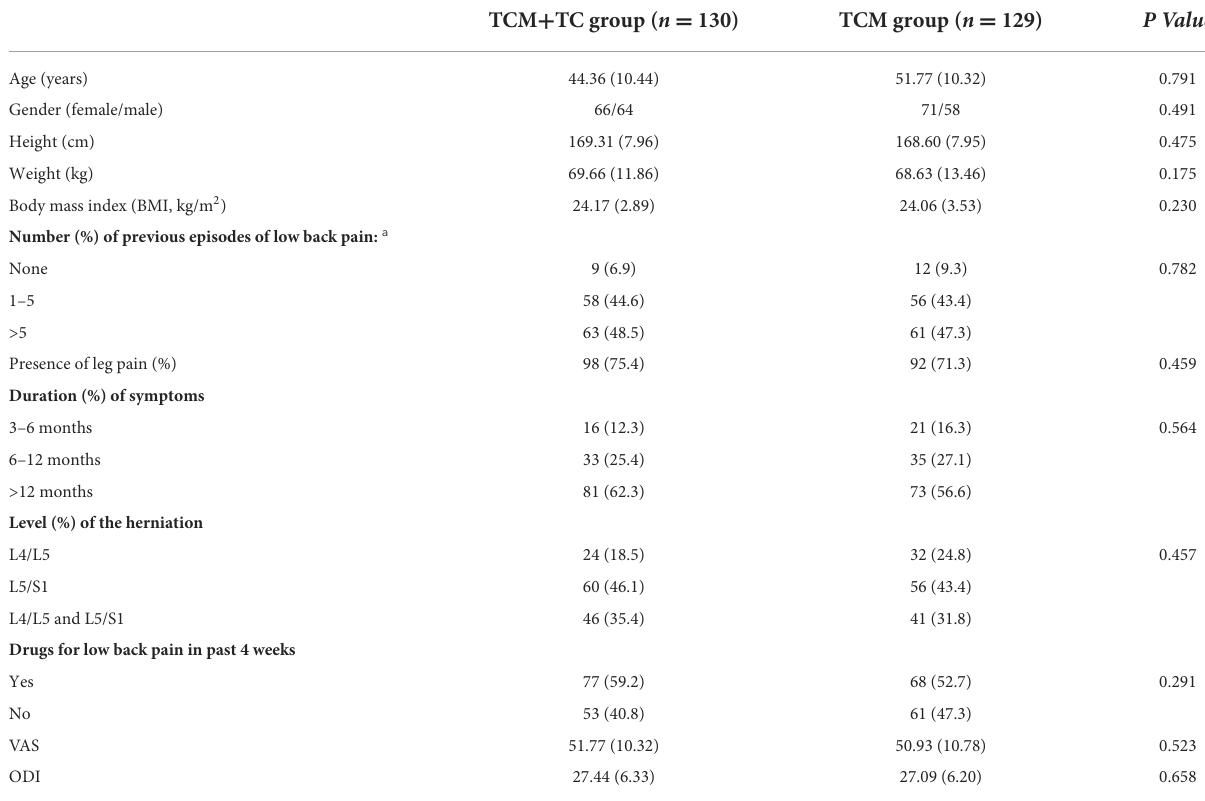
TABLE 1 Baseline demographic characteristics of participants ( N = 259).